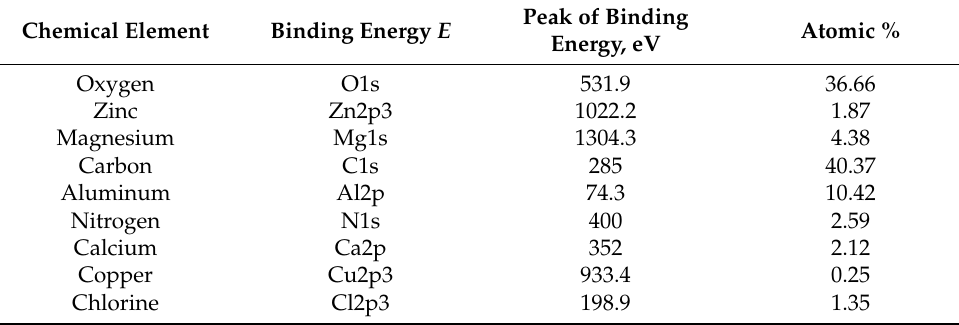
Table 7. X-ray peaks of the 2024 (D16) duralumin sample machined